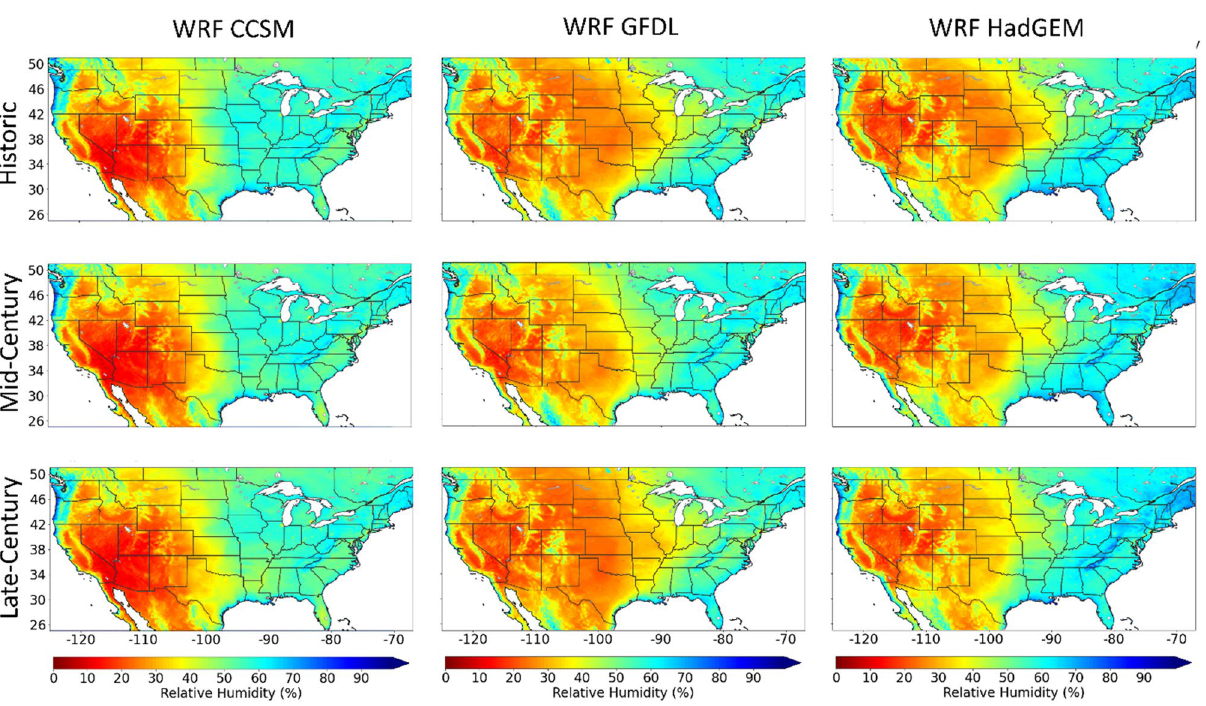
Figure 5. June, July, and August averaged daily minimum relative humidity for each timeframe with WRF CCSM, WRF GFDL and WRF HadGEM. This figure was generated using the Matplotlib 41 library for the Python programming language (https:// matpl otlib.